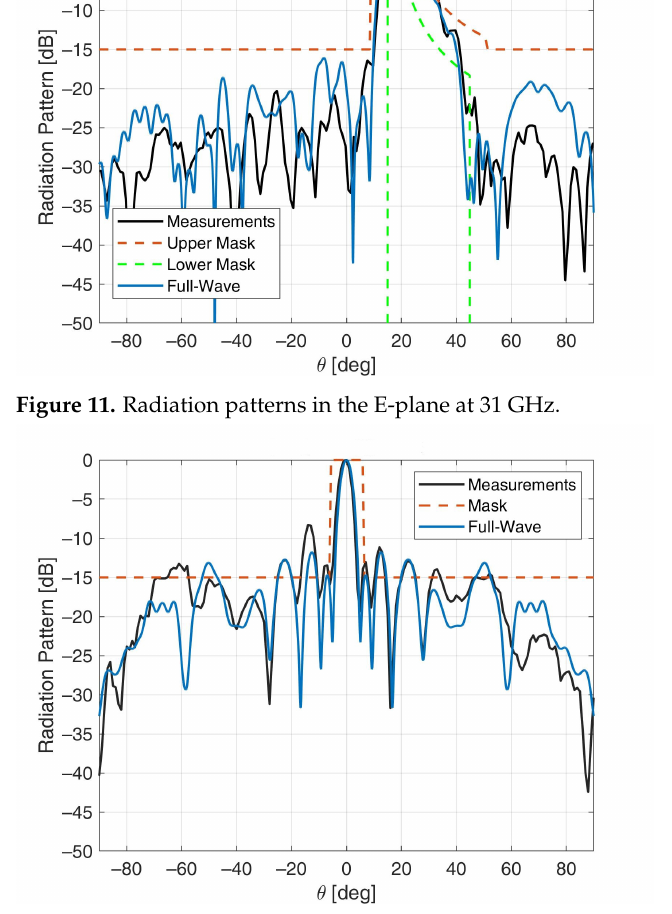
Figure 12. Radiation patterns in the H-plane at 29 GHz.